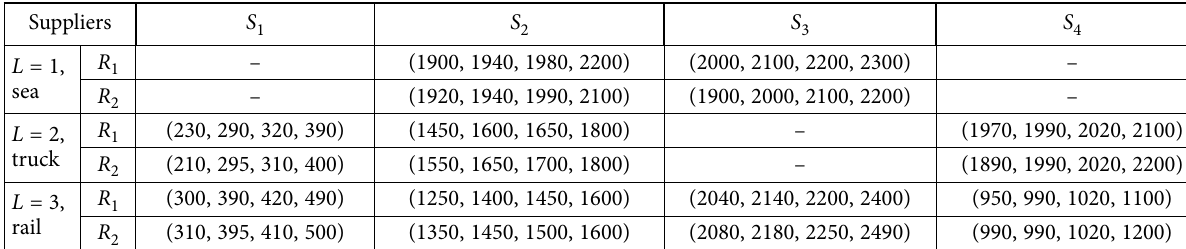
Table 4. TrFN Price and transportation costs from supplier to retailer (USD per ton)